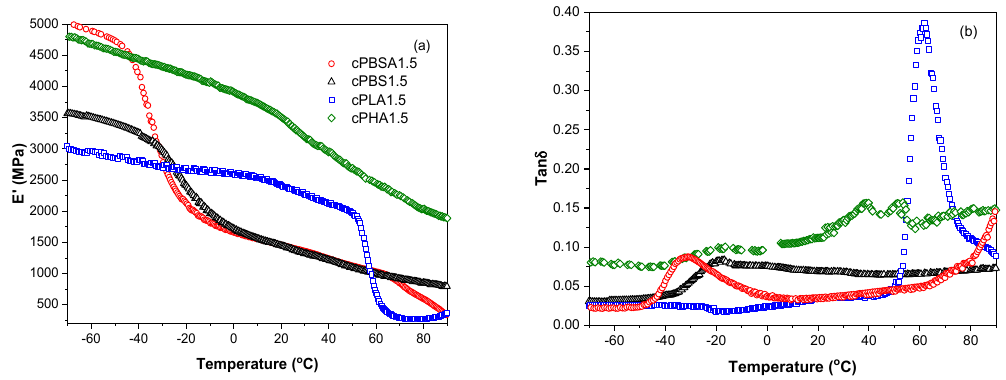
Figure 7. ( a ) Storage modulus and ( b ) tan δ curves for laminates cPBSA1.5, cPBS1.5, cPLA1.5, and cPHA1.5.